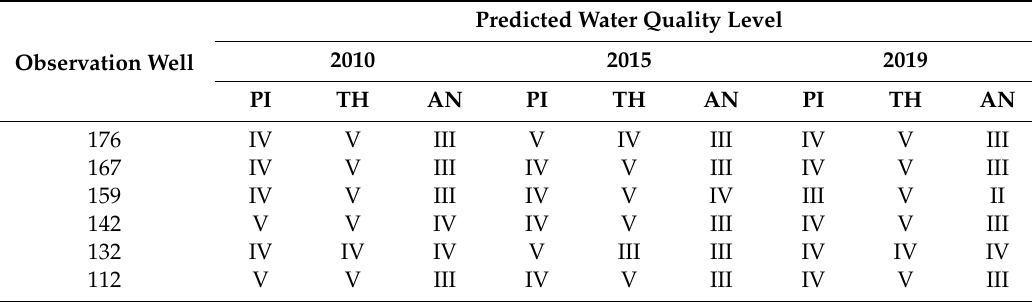
Table 3. Prediction results of water quality level based on the